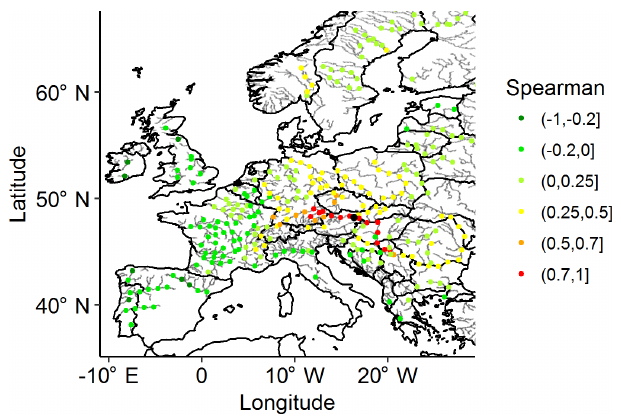
Figure 6. Correlation of descriptors at all representative locations vs. descriptors at Vienna (black